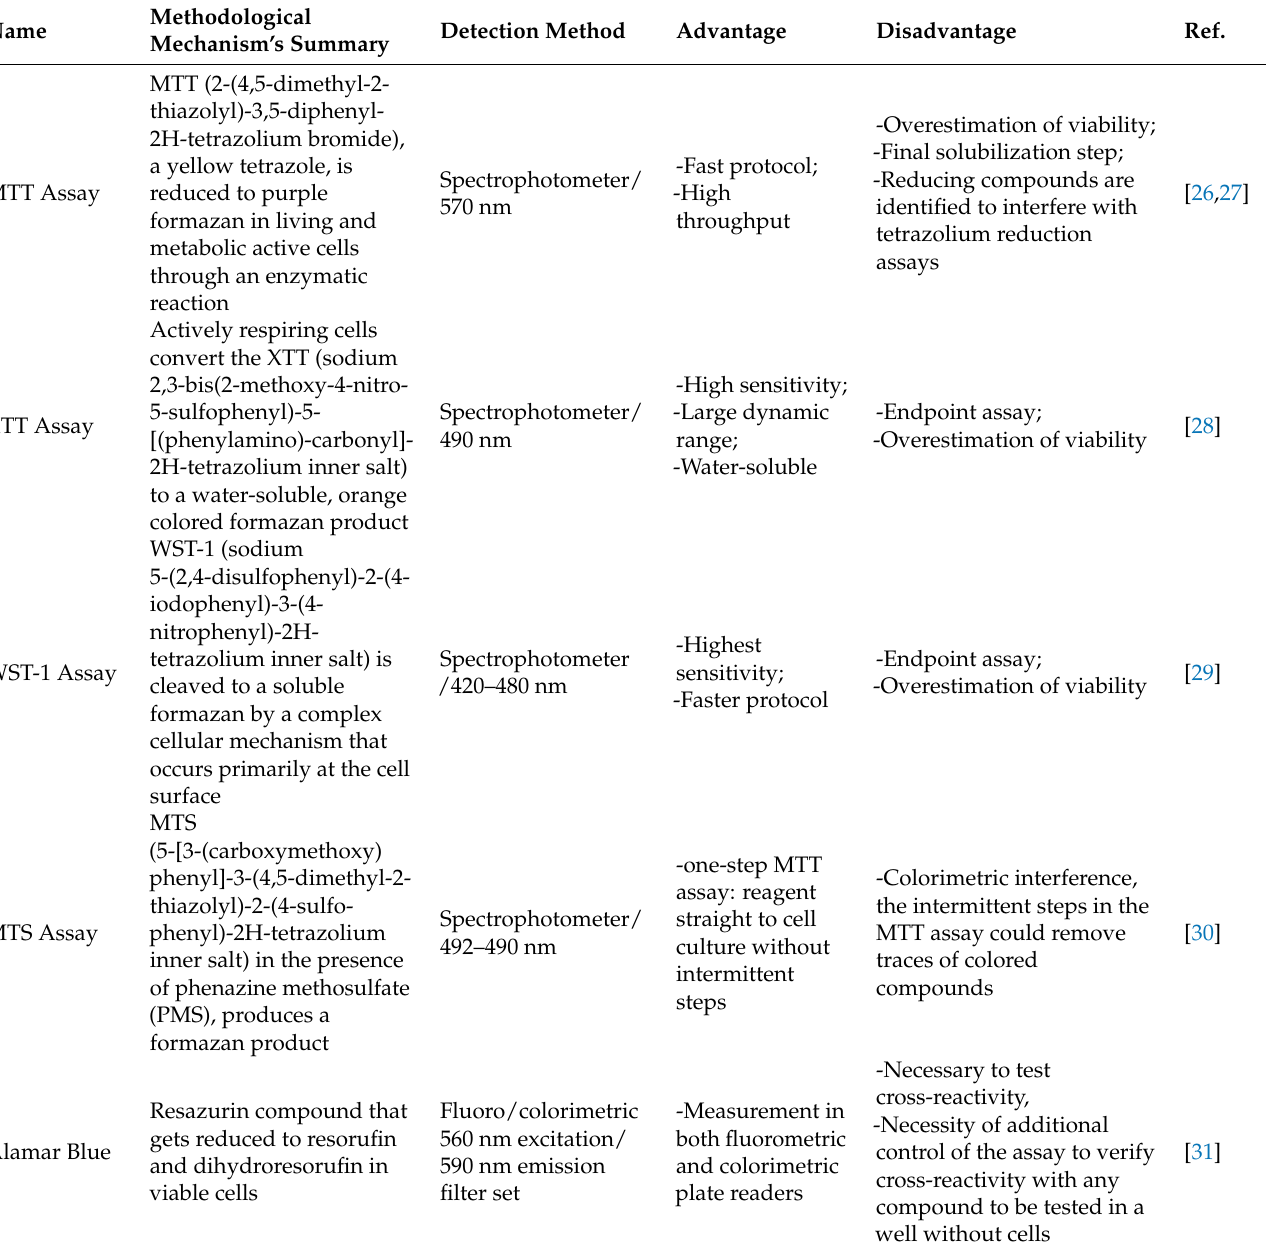
Table 1. Intracellular metabolic assays to measure cellular proliferation, cell viability, and cytotoxicity: their advantages and